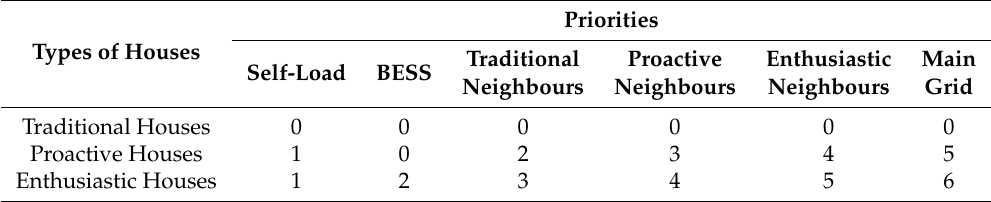
Table 2. Priorities for sharing power in a microgrid with different types of houses during the grid-connected